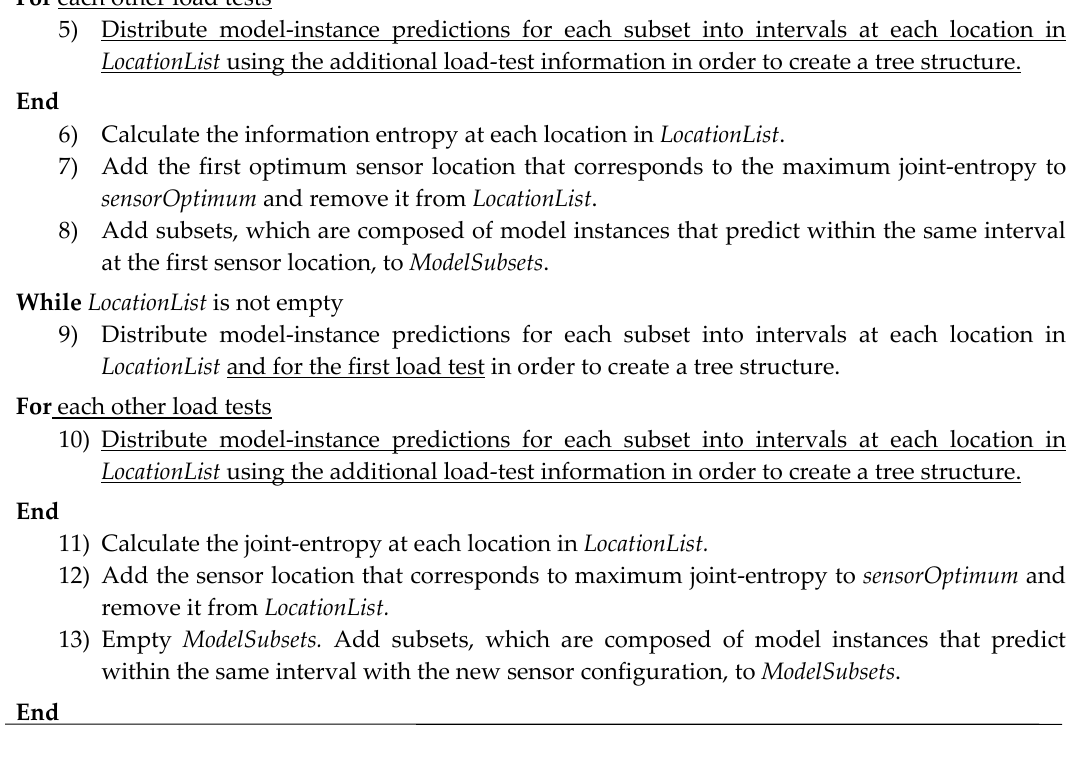
Figure 5. Pseudo-code of the new hierarchical algorithm for multiple load tests within the second